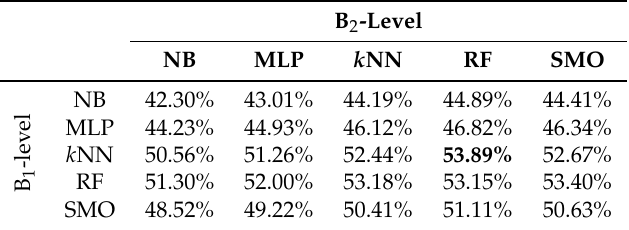
Table 3. Two-level classifier classification using NB as A-level classifier.